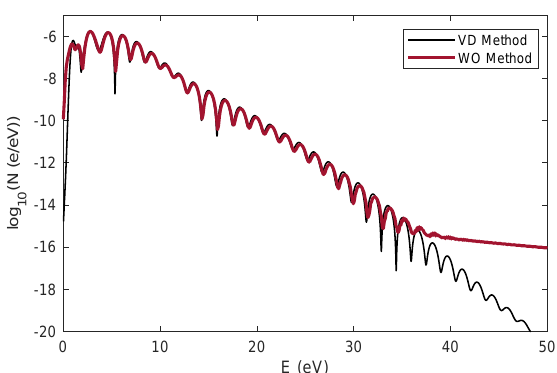
Figure 4. Window operator method (red, bold) and virtual detector method (black) compared for a gas electron rescattering test simulation with φ ce = 0. The WO (window operator) method ideally performs best in the low energies, where electrons have not had time to leave the simulation. However, the noise level (seen on the right as a flattening out) is fairly high and the WO method involves computationally intense post processing. The VD (virtual detector) method may not have measured all of the low energy electrons as they did not make it to the boundary by the end of the simulation. Regardless, the two spectra overlap closely and the VD method also seems to have a lower noise level, all while requiring just a single FFT (fast Fourier transform) in post processing.